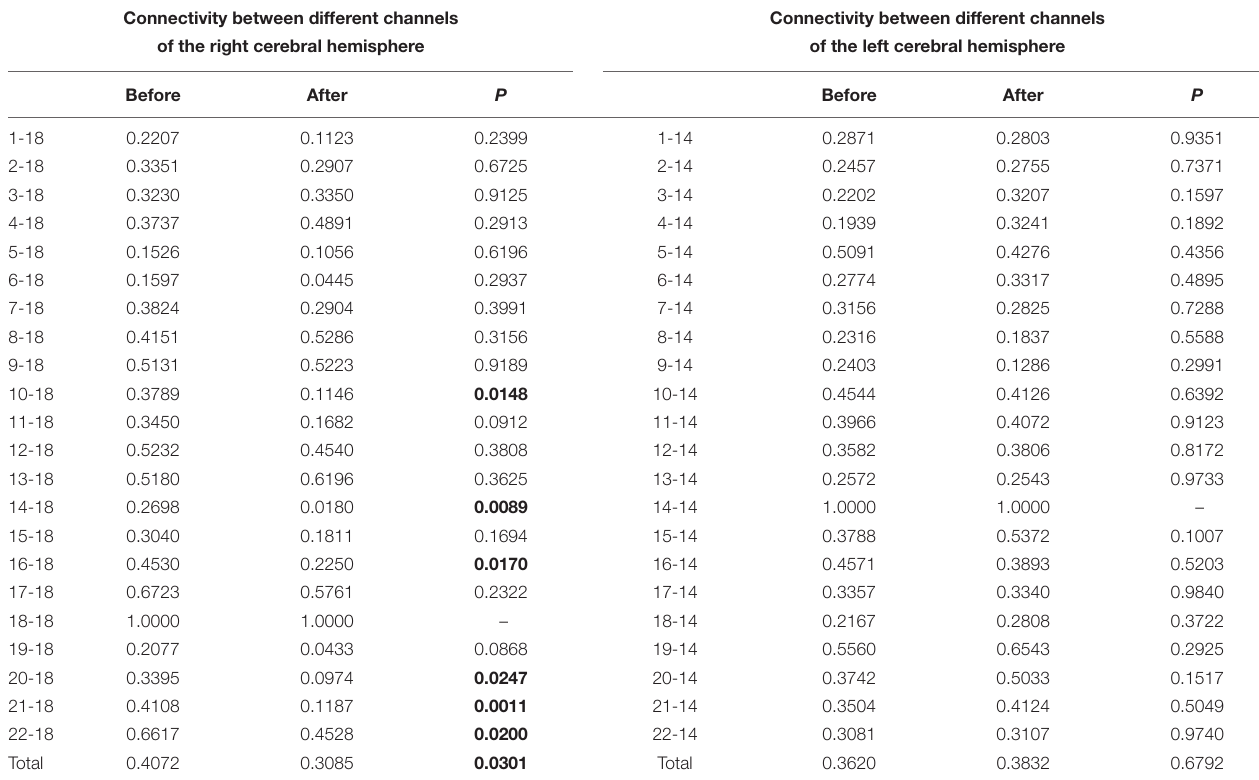
TABLE 4 | Connectivity between BA46 and different